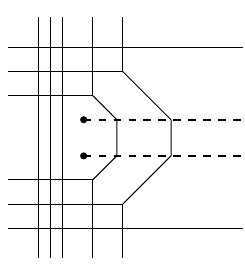
Figure 7 . Brane web realization with the charges of a 4-pole solution with one puncture, as discussed in section 4.5. The number of D5 branes on the left hand side is larger than the number of D5 branes on the right hand side, corresponding to N 1 > N 2 in the supergravity